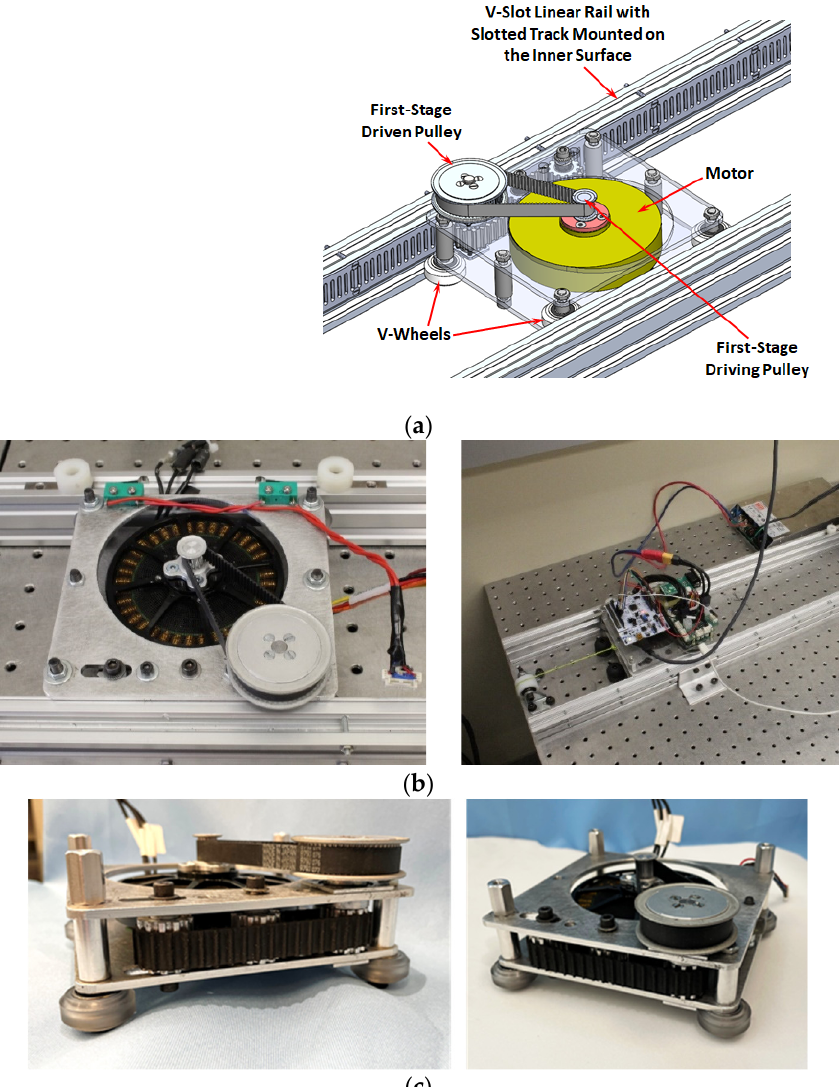
Figure 2. The B-SALD prototype: ( a ) CAD model and the major components; ( b ) photos of the assembled device; ( c ) photos of the driving mechanism of the moving